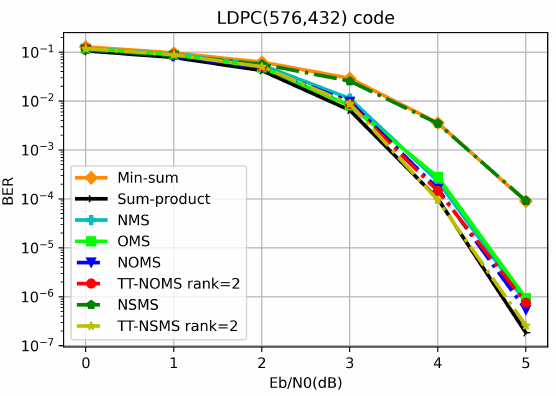
Figure 6. BER performance of TT-NOMS, TT-NSMS, NOMS [22] and NSMS algorithms for LDPC(576,432)